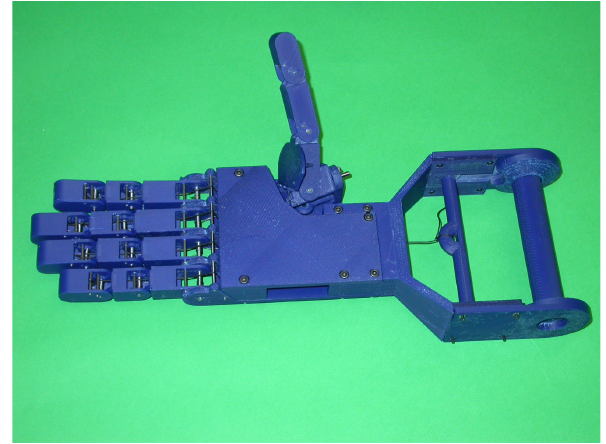
Figure 2. Prototype of underactuated hand proposed in Gosselin et al.